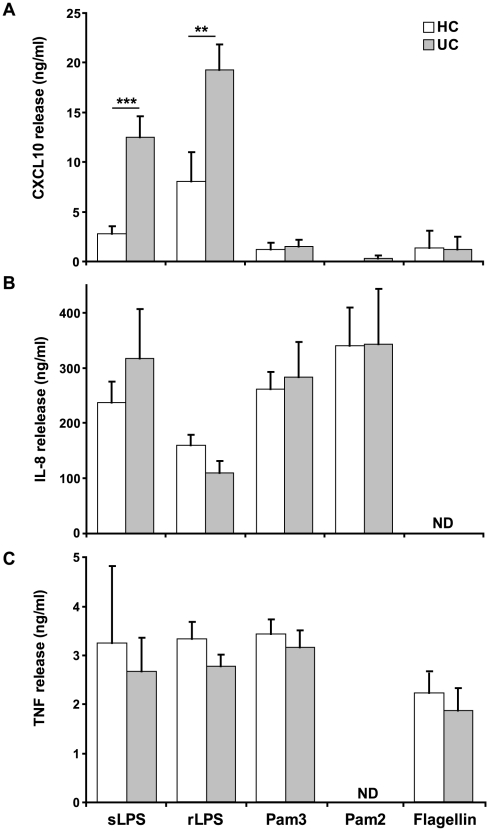
Macrophages from UC patients demonstrate defective cytokine release downstream of TLR4.Macrophages from UC (n = 12) and HC (n = 8) were stimulated for 24 h with sLPS (TLR4/CD14), rLPS (TLR4), Pam3CSK4 (TLR2/1), Pam2CSK4 (TLR2/6) and flagellin (TLR5). Secreted levels of (A) CXCL10, (B) IL-8 and (C) TNF-α were measured. Results are expressed as a mean ± SEM (**p<0.01, ***p<0.001) (ND  =  not determined).